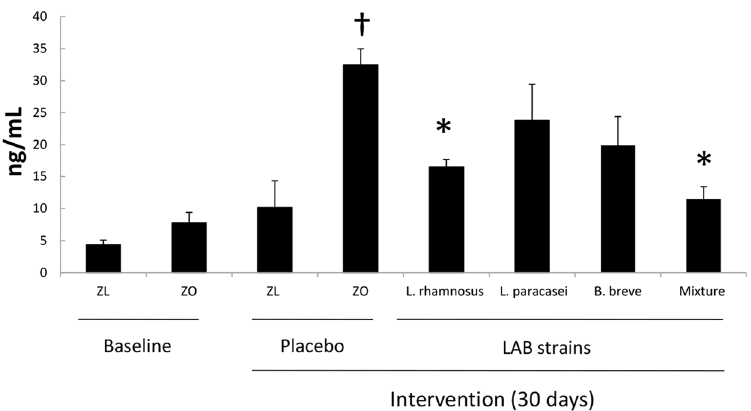
Figure 6. Lipopolysaccharide binding protein (LBP) concentrations in serum of Zucker lean Lepr + / fa rats and Zucker-Lepr fa / fa rats that were fed either a placebo or probiotic strains for 30 days. Values are expressed as the mean ± SEM, n = 8 rats per group. † P < 0.05 versus ZL placebo, and * P < 0.05 versus ZO placebo. ZL, Zucker lean Lepr + / fa rats; ZO, Zucker-Lepr fa/fa